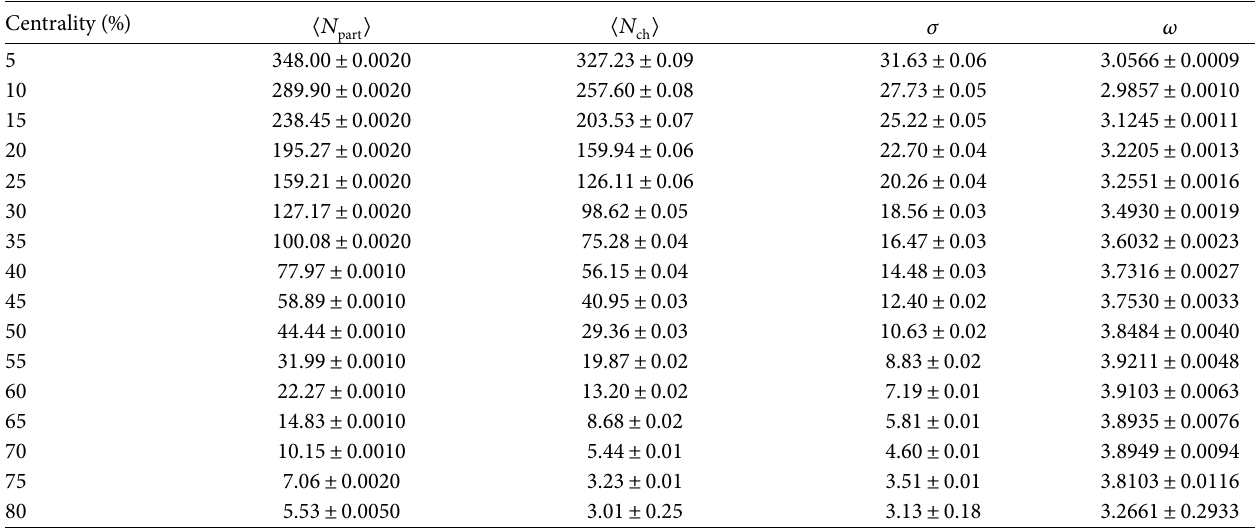
Table 3: Values of the same variables, as in Table 1, but for 𝐸 lab = 30A GeV/c. Centrality ( %